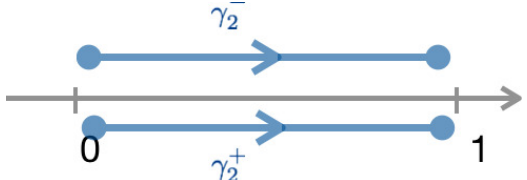
Figure 2. Integration contours present in the evaluation of three point kinematic